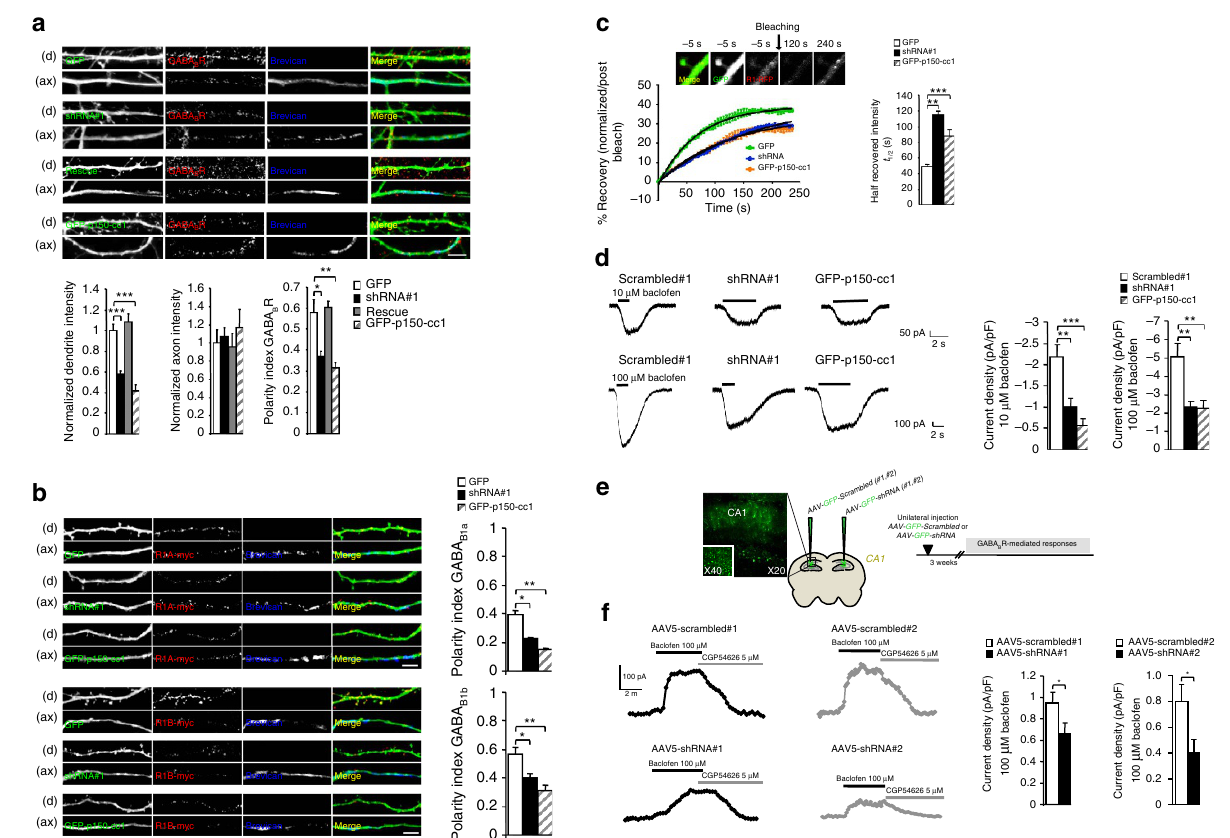
Figure 4 | Association of Shrm4 with dynein/dynactin drives GABA B Rs dendritic transport. ( a ) Images of dendrites (d) and axons (ax) of hippocampal neurons at 14 DIV , transfected with GFP (control), knockdown (shRNA#1), rescue, or GFP-p150-cc1 at 8 DIV . The mean fluorescence intensities of GABA B Rs are shown with a polarity index (PI ¼ ( I d (cid:2) I a )/( I d þ I a )). For uniformly distribution PI ¼ 0, whereas for dendritic polarization PI 4 0, and for axonic polarization PI o 0. GABA B R immunostaining was reduced in dendrites in knockdown and GFP-p150-cc1-expressing neurons compared with those for control and rescue neurons (Left histograms, n ¼ 10, 10, 15, 10; *** P o 0.0001; F(3,41) ¼ 21.91; one-way ANOVA-Mann–Whitney). In addition, the mean PI of shRNA#1- and GFP-p150-cc1-expressing neurons is also reduced (right histograms, n ¼ 10, 10, 15, 10; *** P o 0.0001; F(3,41) ¼ 14.72; One-way ANOVA-Mann–Whitney). Scale bar, 10 m m. ( b ) Images, mean fluorescences and PIs for dendrites (d) and axons (ax) of 14DIV hippocampal neurons co-transfected with GFP (control), knockdown- (shRNA#1) or GFP-p150-cc1 together with either GABA B1a -myc or GABA B1b -myc at 8 DIV . GABA B1 was detected with anti-myc and brevican identified the axons. Histograms show mean ± s.e.m.; GabaB1a: n ¼ 10–15; *** P o 0.0001; F(2,27) ¼ 49.75; one-way ANOVA-Mann–Whitney; GABAB1b: n ¼ 10–15; *** P ¼ 0.0001; F(2, 27) ¼ 12.53; one-way ANOVA-Mann–Whitney. Scale bar, 10 m m. ( c ) Fluorescence recovery after photobleaching (FRAP) of cultured hippocampal neurons expressing GABA B1 -RFP together with GFP, shRNA#1 or GFP-p150-cc1. The mean half-time ( t 1/2 ) for fluorescence recovery (fluorescent recovery post-bleach corrected to 0%) is significantly longer in knockdown and GFP-p150-cc1-expressing neurons than GFP control. Histograms show mean ± s.e.m.; n ¼ 7; *** P ¼ 0.0002; F(2,15) ¼ 16.43; one-way ANOVA-Mann–Whitney. ( d ) Whole-cell GIRK currents recorded in response to GABA B R activation by 10 (top) or 100 (bottom) m M baclofen, from rat hippocampal neurons at 14 DIV , transfected either with scrambled, knockdown (shRNA#1) or GFP-p150-cc1 at 8 DIV . Baclofen-activated (10 and 100 m M) GIRK current densities in Shrm4-silenced, dynein-inhibited neurons and scrambled shRNA neurons are shown. Histograms show mean ± s.e.m.; 10 m M: n ¼ 10, 10, 11; *** P ¼ 0.0003; F(2,28) ¼ 10.96, one-way ANOVA-Mann–Whitney; 100 m M: n ¼ 10, 9, 12; *** P ¼ 0007; F(2,28) ¼ 9.466). ( e ) Schematic of injection of AAV5-scrambled#1 (or #2) and AAV5-shRNA#1 (or #2) into opposing CA1 areas of rat, with time line for recovery and experiments. ( f ) Representative traces and histograms showing changes in GIRK and current densities (pA/pF) from CA1 pyramidal neurons evoked by baclofen (100 m M, horizontal bars) and blocked by the selective GABA B R antagonist, CGP54626 (5 m M). Histograms show mean ± s.e.m.; n ¼ 10; (left histogram shRNA#1: * P ¼ 0.0298; t -test; right histogram shRNA#2: * P ¼ 0.0471, t -test).